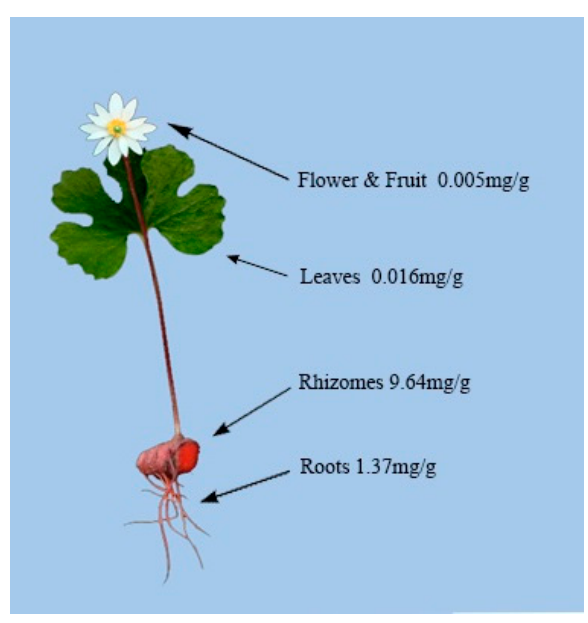
Figure 2. Average annual Sanguinarine concentrations in S. canadensis [90].